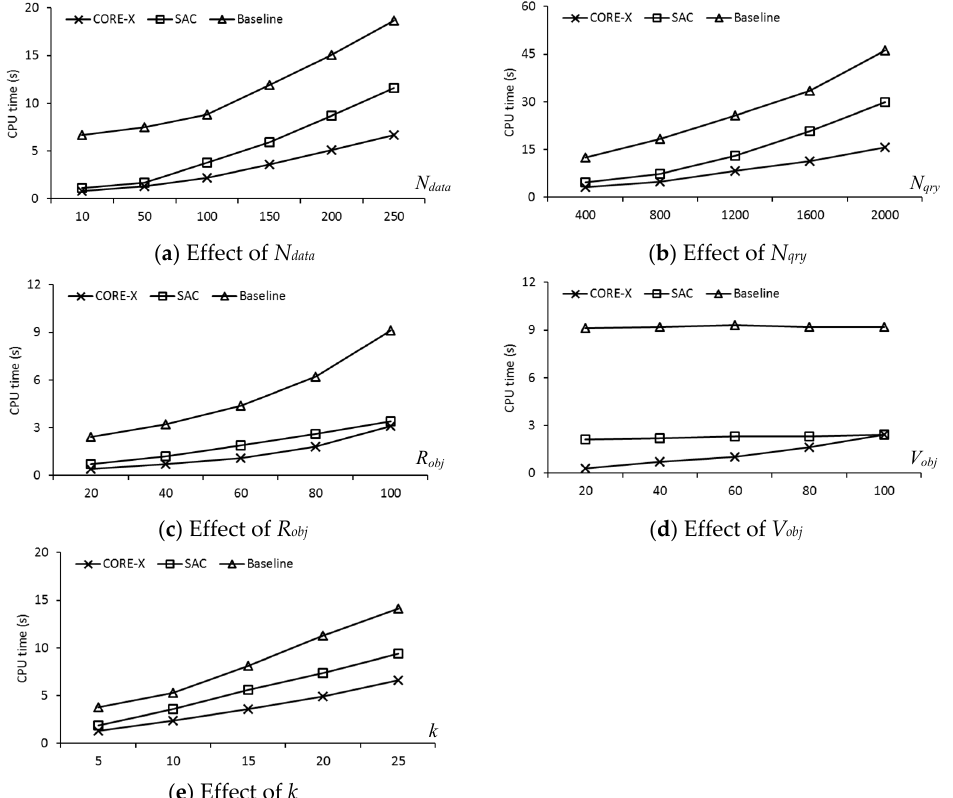
Figure 14. Comparison of computational cost. ( a ) Effect of N data ; ( b ) Effect of N qry ; ( c ) Effect of R obj ; ( d ) Effect of V obj ; ( e ) Effect of k.